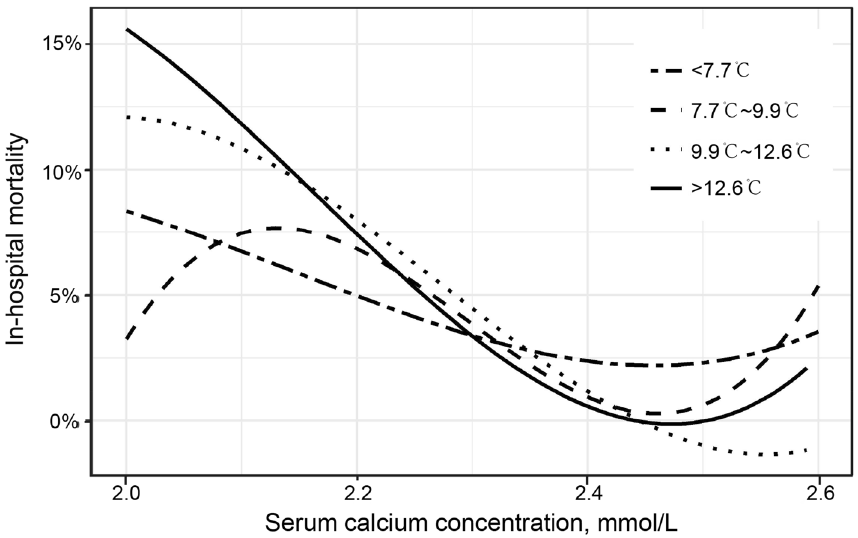
Figure 3. Spline plots displaying the risk of in-hospital mortality over a range of serum calcium concentrations stratified by quartiles of diurnal temperature range (DTR). Smooth curve fitting revealed an L-shaped relationship of in-hospital mortality with serum calcium concentration for the third and fourth quartiles of